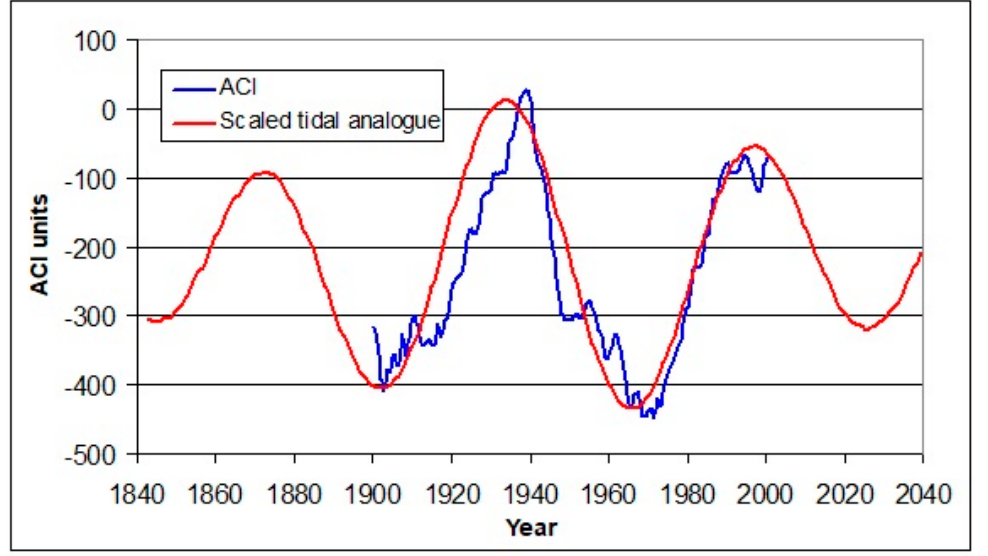
Figure 1. The accumulated balance over time of zonal minus meridional components in the Atmospheric Circulation Index (ACI), compared with the tidal zonal (59.75-year) minus meridional (86.81-year) differences. The tidal curve is vertically scaled to the ACI anomaly in Leonid Klyashtorin’s [4] zonal units.